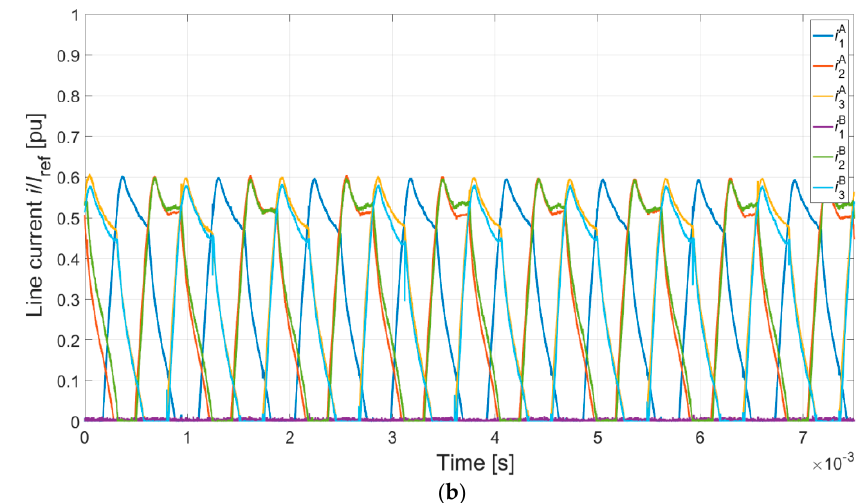
Figure 14. Relative line currents in DCO mode at open phase in channel B—laboratory test: (a) DCBLDCM; (b) DCSRM.